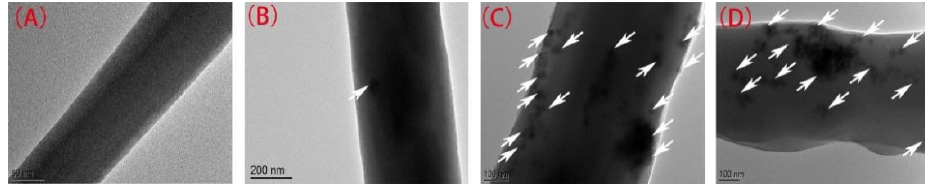
Figure 2. TEM images of PVDF–PVP ( A ), PVDF–PVP–TiO 2 2% ( B ), PVDF–PVP–TiO 2 5% ( C ), and PVDF–PVP–TiO 2 10% ( D ) fibers containing nanoscale (white arrows).